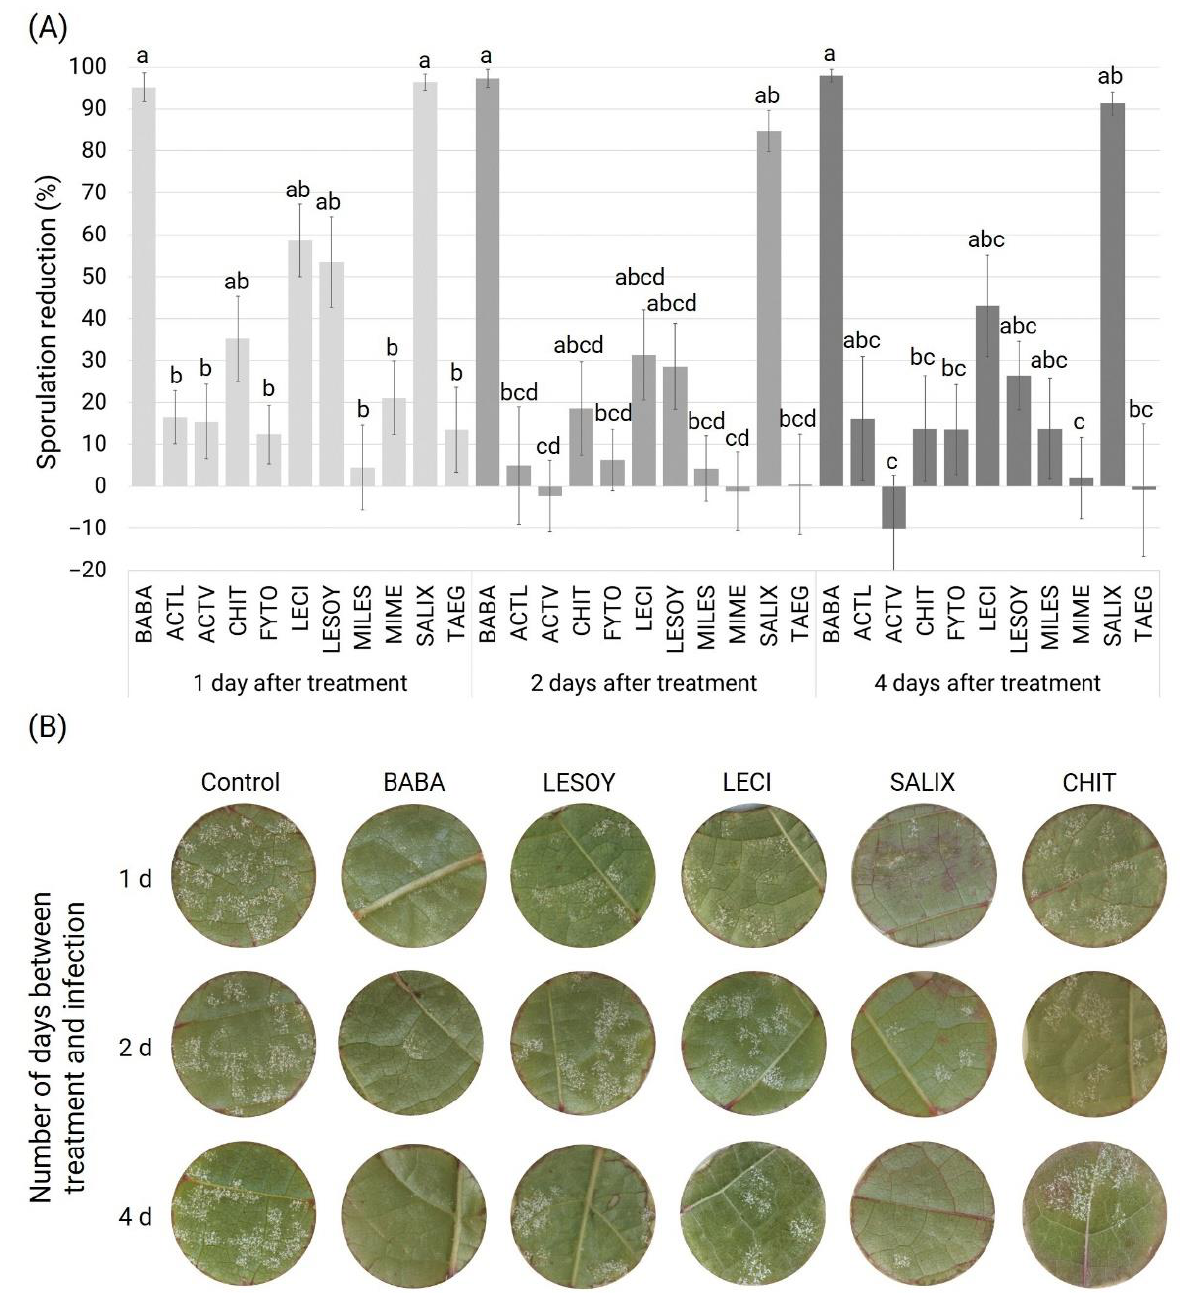
Figure 1. CHIT, LECI, LESOY, and SALIX, as the control BABA showed a good preventive protection against downy mildew, as opposed to the rest of the studied products. ( A ) Preventive activity of the commercial products against P. viticola (Table 1). The graph shows the average reduction of sporulation of discs infected at 1, 2 and 4 days after treatment or product application. A Dunn’s post-hoc test ( α = 0.05) was performed for each timepoint to find statistical differences between products within the same timepoint, which are denoted by different small letters in the bar graph. ( B ) Visual evidence of the preventive capacity of BABA, LESOY, LECI, SALIX and CHIT seven days after pathogen inoculation. The columns show the different treatments, and the row shows the number of days between the treatment and P. viticola sporangia inoculation.